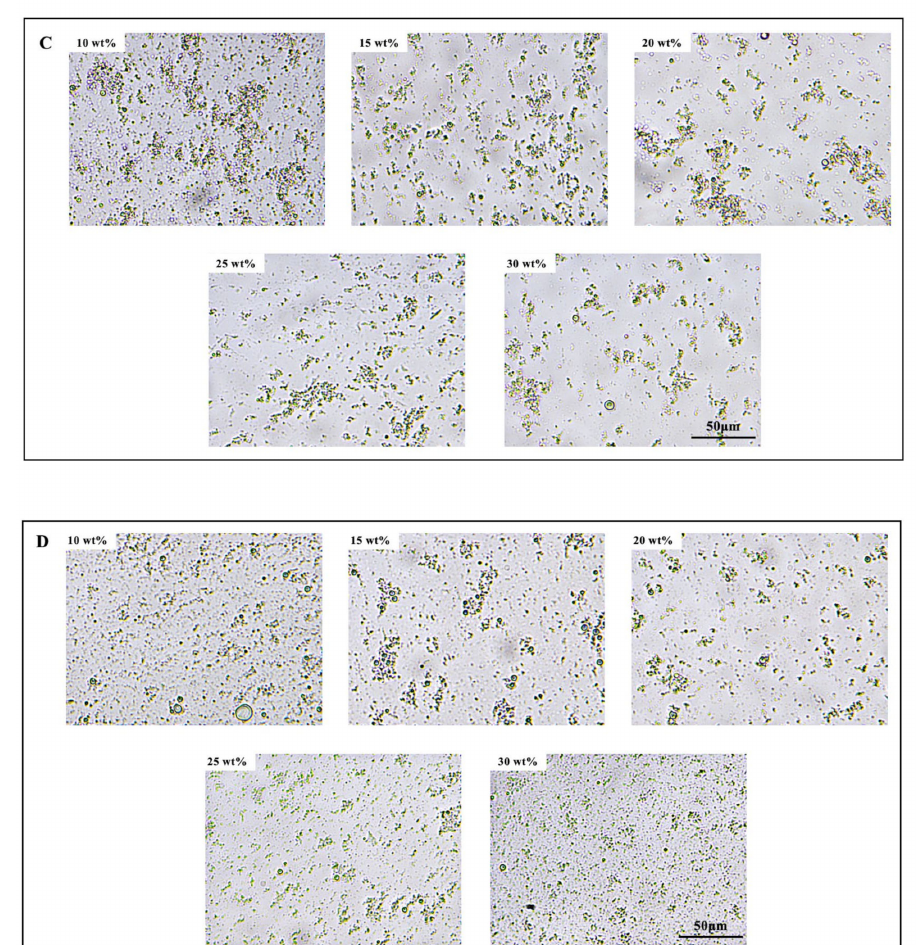
Figure 1. Particle size distribution and microstructure of the emulsions at different sugar concentra- tions. ( A , B ) represent particle size distribution of the emulsions with glucose ( A ) and corn syrup ( B ) before whipping. ( C , D ) represent microstructures of the emulsions with glucose ( C ) and corn syrup ( D ) before whipping, respectively. Different letters of a–e indicate significant differences ( p < 0.05) among the various sugar levels. Different letters of x, y indicate significant difference ( p < 0.05) between glucose and corn syrup in the same